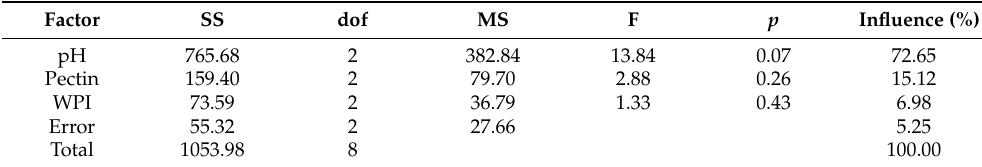
Table 2. Analysis of variance (ANOVA) for the three factors tested.